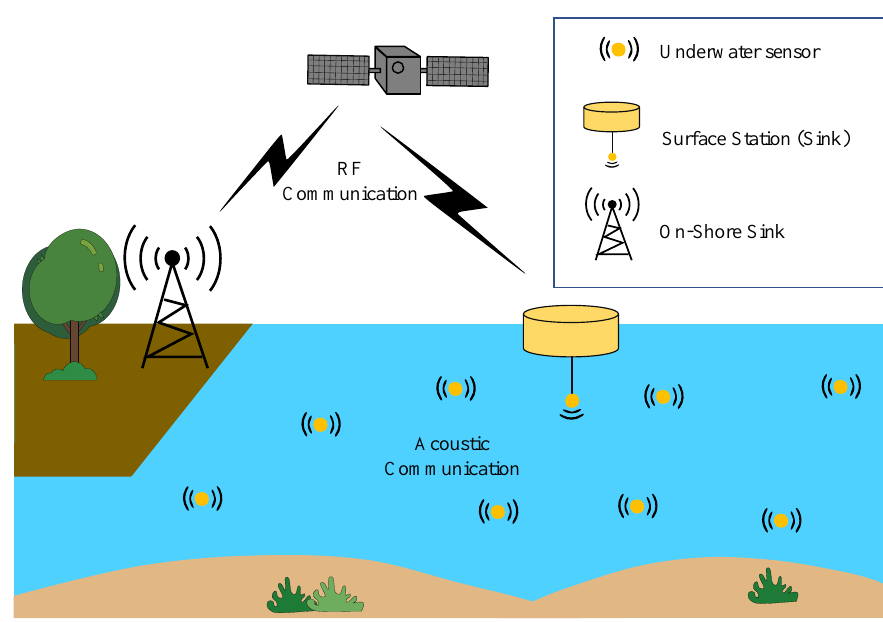
Figure 1. The architecture of an underwater sensor network.